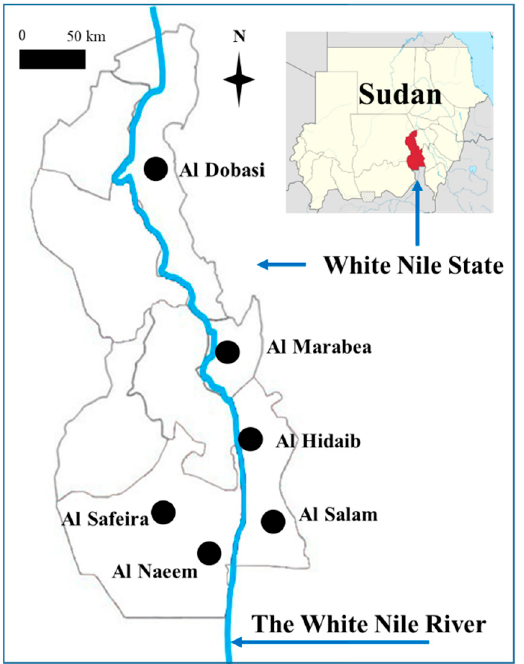
Figure 1. Study area (five primary schools in White Nile State, Sudan; blue line: the White Nile River).